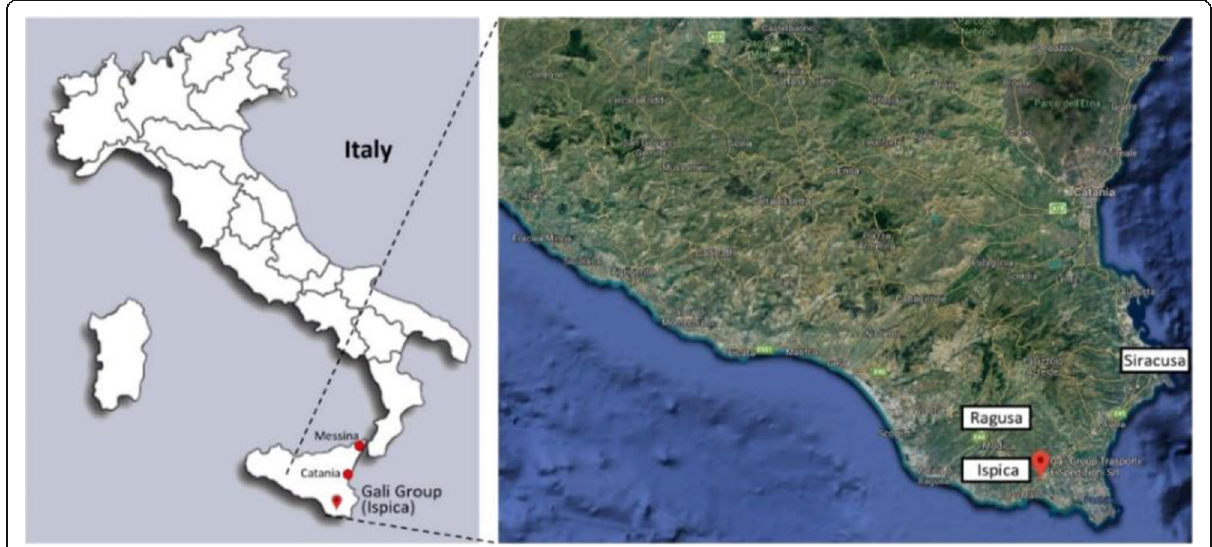
Fig. 3 Satellite Images of the study area (https://satellites.pro/)